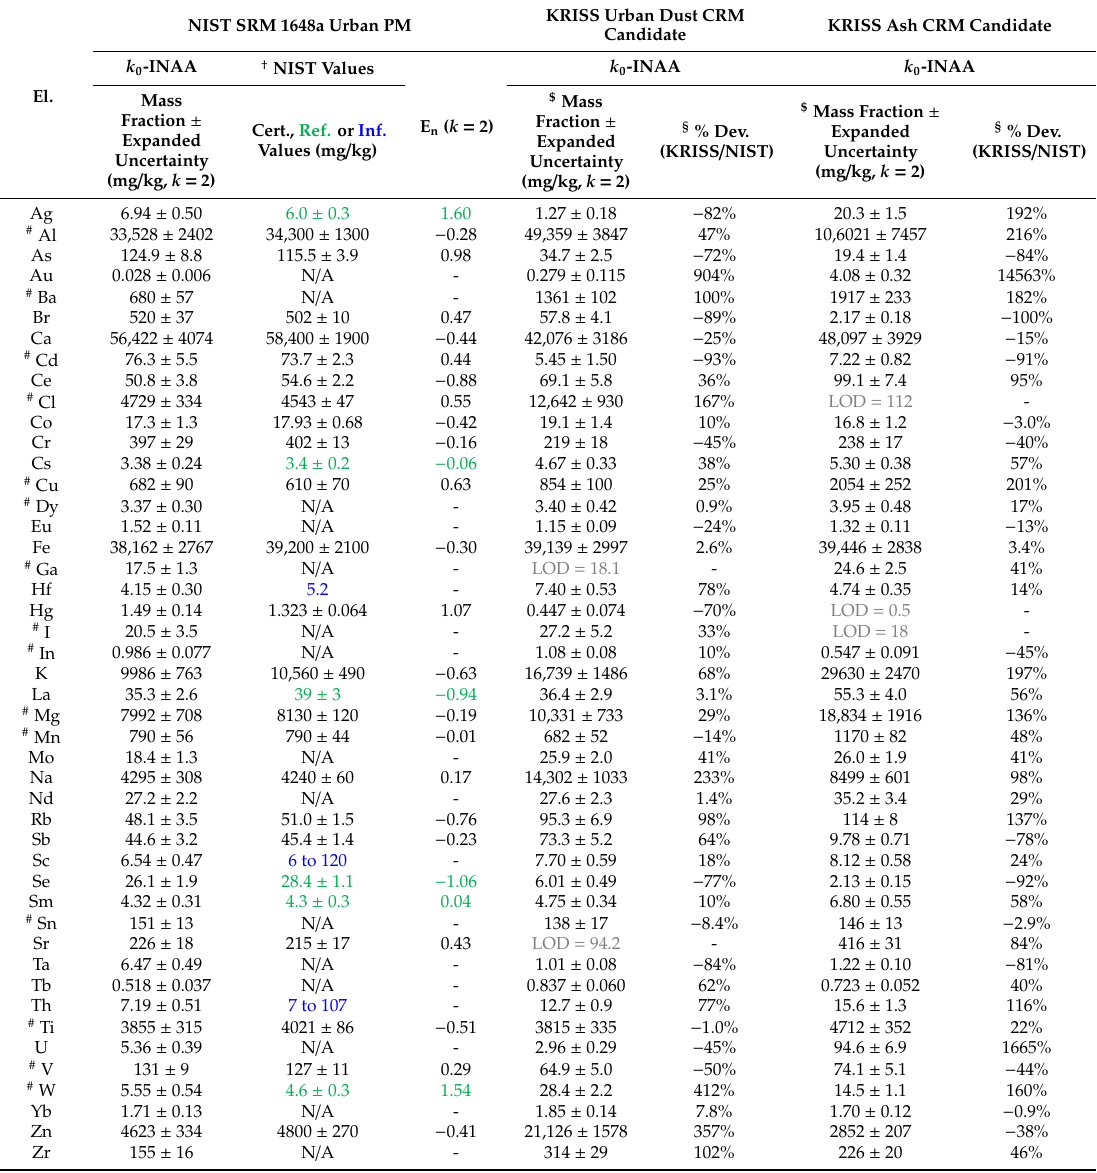
The values represented as N / A are not available. † Among the values provided by NIST, the black color values are the certified values, the green values are the reference values, and the blue values can be used as information only. $ Gray colored characters represent LODs of elements not presents above the detection limit of k 0 -INAA method. § Thepercentage(%)deviationcalculatedas(KRISS k 0 -INAAvalue–NIST1648a k 0 -INAAvalue) / NIST1648a k 0 -INAA value × 100. # The values labeled with # are not accredited according to the Accreditation Certificate